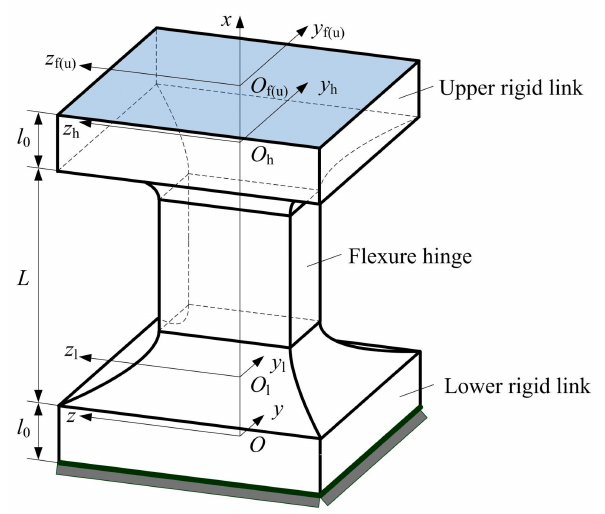
Figure 9. Geometric relationships among coordinate frames of two-axis elliptical-arc-filleted flexure hinge with two rigid